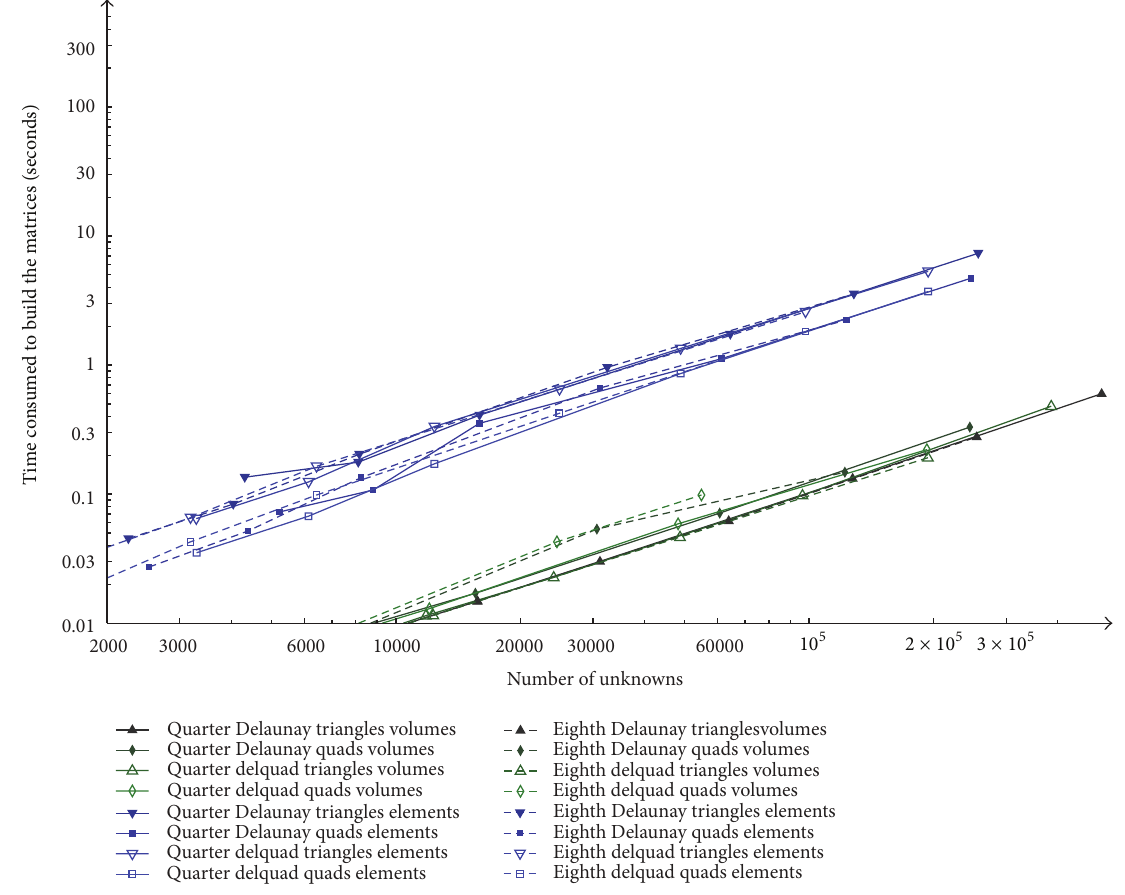
Figure 23: Time needed to build the matrices versus number of